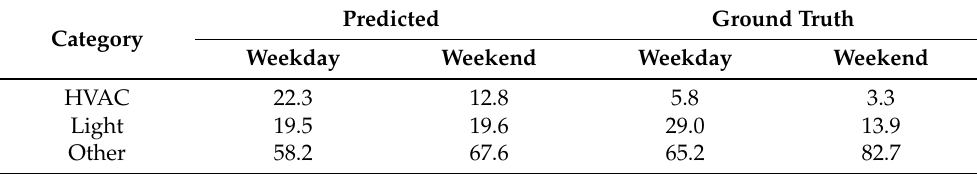
Table 11. Daily average Energy Shares [%] per tertiary disaggregation category on test